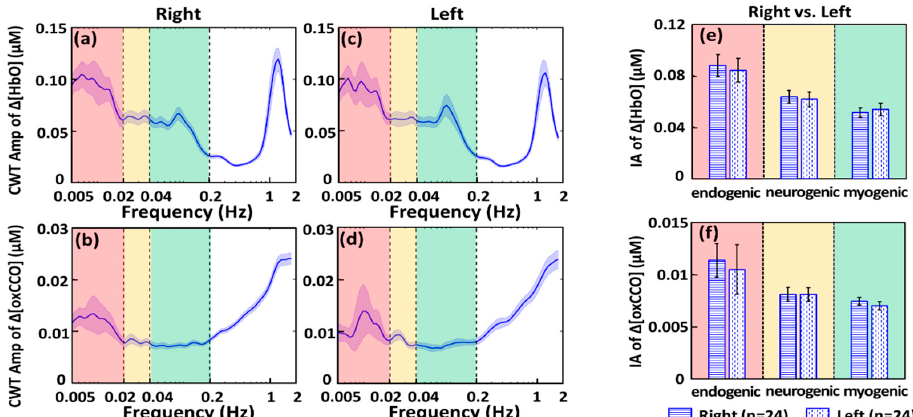
Figure 1. CWT-derived amplitude (Amp) spectra in resting state at the group level ( n = 24) of ( a ) right prefrontal ∆ [HbO]; ( b ) right prefrontal ∆ [oxCCO]; ( c ) left prefrontal ∆ [HbO]; and ( d ) left prefrontal ∆ [oxCCO]. The blue-shaded band along each spectral curve marks the respective standard error of the mean. The red-, yellow-, and green-shaded boxes denote the endogenic, neurogenic, and myogenic frequency bands, respectively. Bilateral comparisons of spectrally averaged index of amplitude (IA) are shown for ( e ) ∆ [HbO] and ( f ) ∆ [oxCCO] from the resting prefrontal cortex of 24 bbNIRS measurements. Error bars indicate the standard error of the mean ( n = 24).